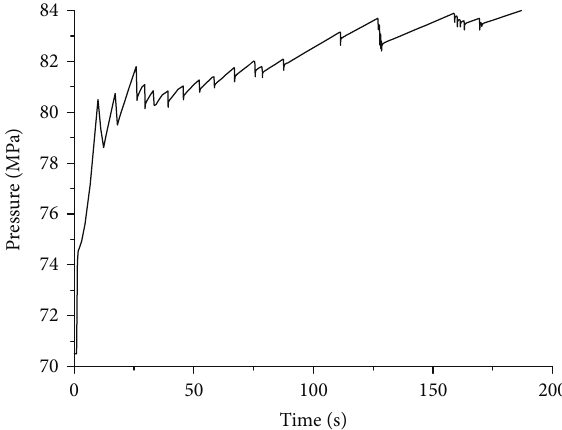
Figure 12: Pressure curve at the NF approaching angle of 30 ° and stress anisotropy coe ffi cient of